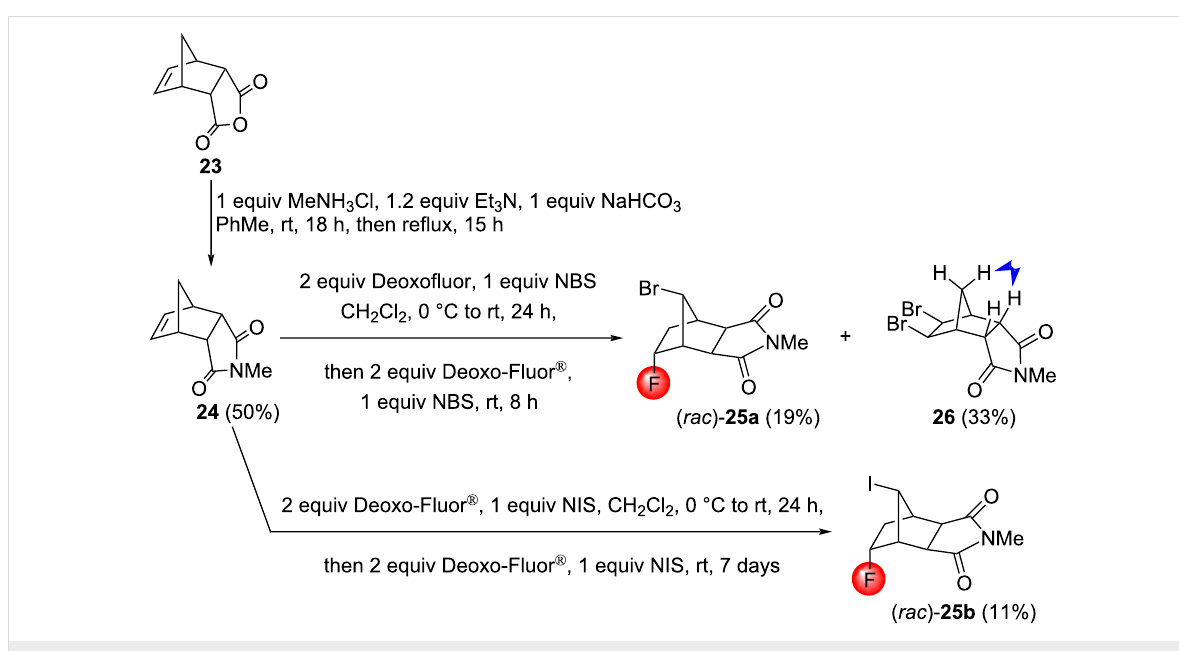
Scheme 14: Synthesis and halofluorination of the imide 24